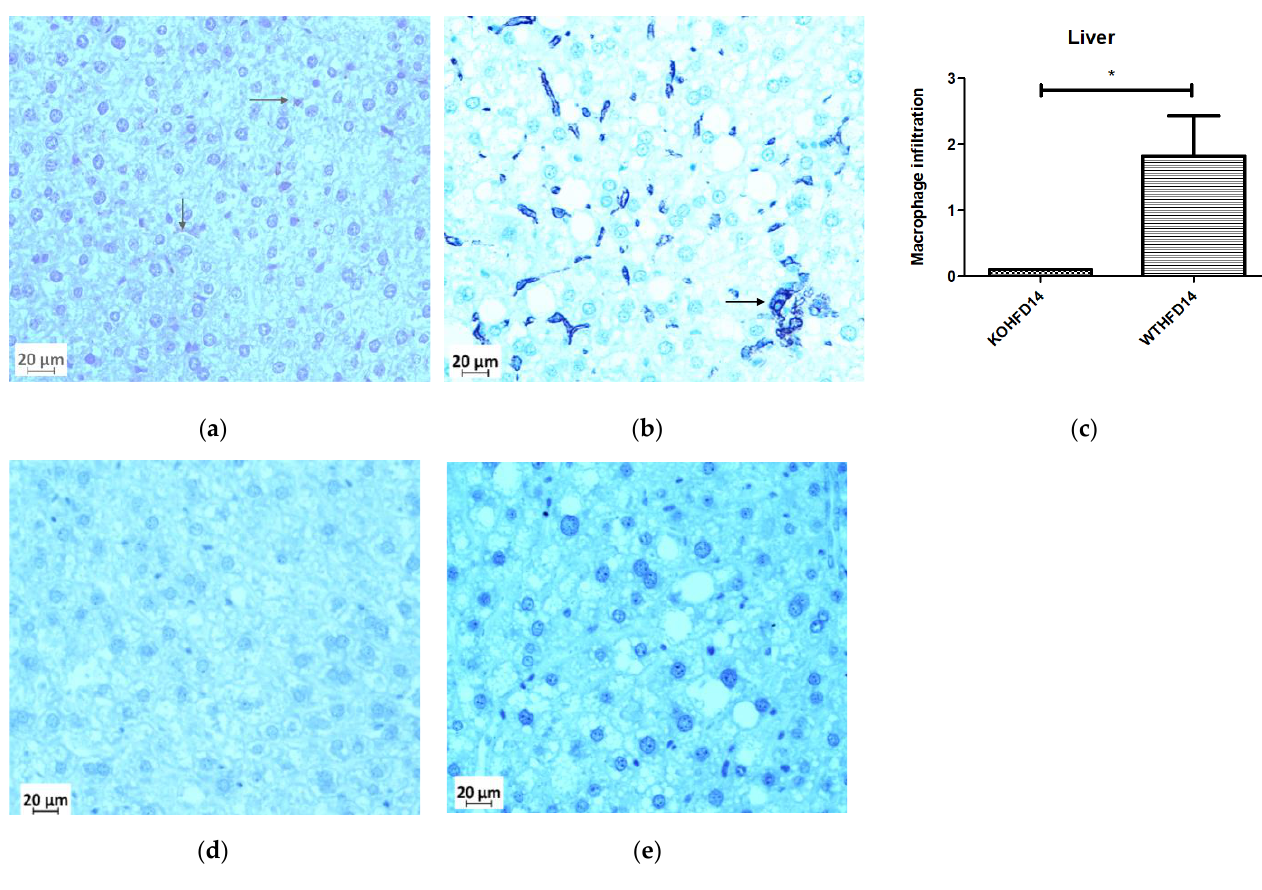
Figure 12. Effect of slc7a8 deletion on the presence of macrophages in the liver. WTHFD ( b ) had significantly greater infiltration ( p < 0.05) ( c ) of macrophages than KOHFD, ( a ). Negative controls for KOHFD ( d ) and WTHFD ( e ); no macrophages were detected. Magnification = 40×. Scale bar = 20 µm. N = 10 fields. * p < 0.05.